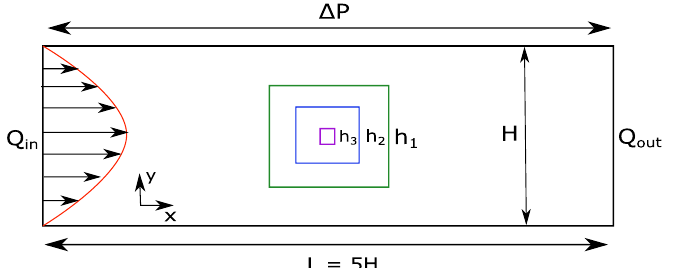
Figure 1. Schematic of the problem: 2D Planar Poiseuille flow in a micro-channel with a stationary obstacle in the middle. Note that the particle is square shaped with sides h1, h2 or h3 (decreasing in size), giving blockage ratios ( H / h ) 2, 4 and 8, respectively. The flow is along the x